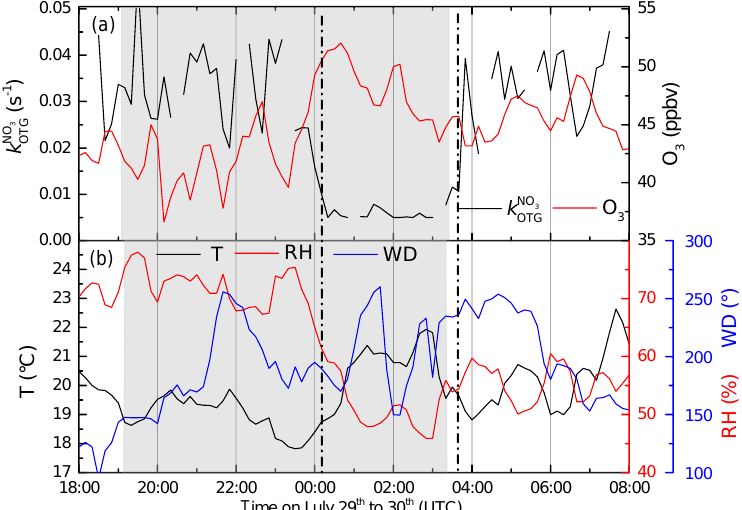
Figure 2. (a) k NO 3 (black) and O 3 mixing ratios (red) from 29 to 30 July. From 23:50UTC until sunrise the measurement site is located in OTG the residual layer and free troposphere. (b) Temperature ( T ), relative humidity (RH), and wind direction (WD) during the same period.